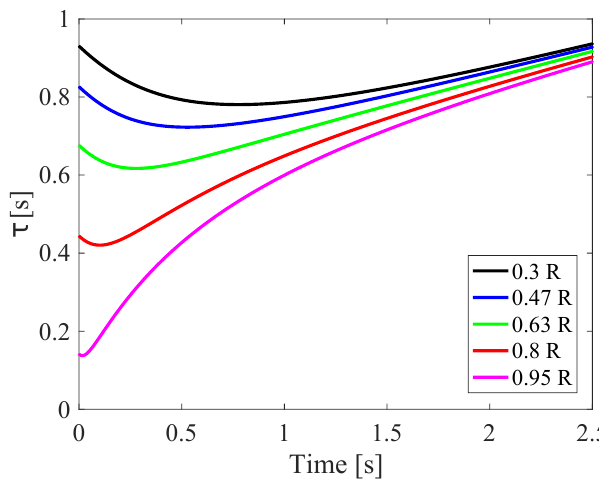
Figure 4. Estimated dynamic inflow time constants at different ra- dial stations depending on the length of the vortex wake behind the rotor